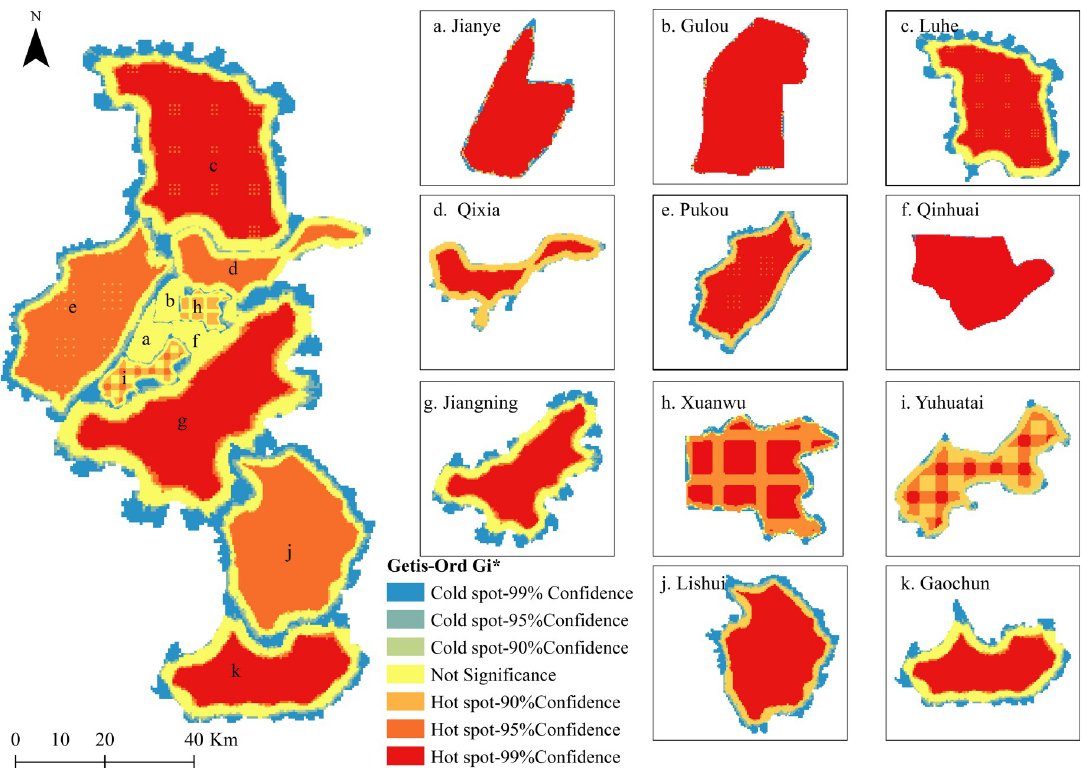
Fig 3. Hot spot analysis of LST. Hot spot analysis of Land surface temperature (LST). (a) Jianye; (b) Gulou; (c) Luhe; (d) Qixia; (e) Pukou; (f) Qinhuai; (g) Jiangning; (h) Xuanwu; (i) Yuhuatai; (j) Lishui; (k) Gaochun. This map is drawn by the authors. This map was created using ArcGIS 1 software by Esri, © National Platform for Common Geospatial Information Services, © OpenStreetMap and contributors, Creative Commons Attribution 4.0(CC BY